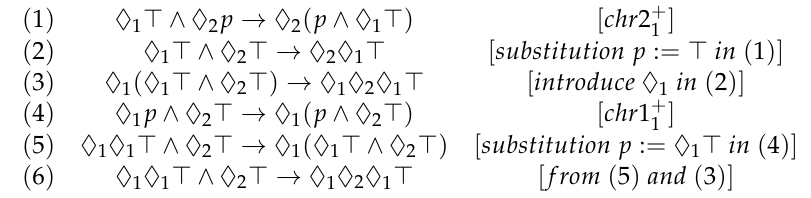
(cid:48) and chr 2 + (cid:48) serve as substitution slots n n